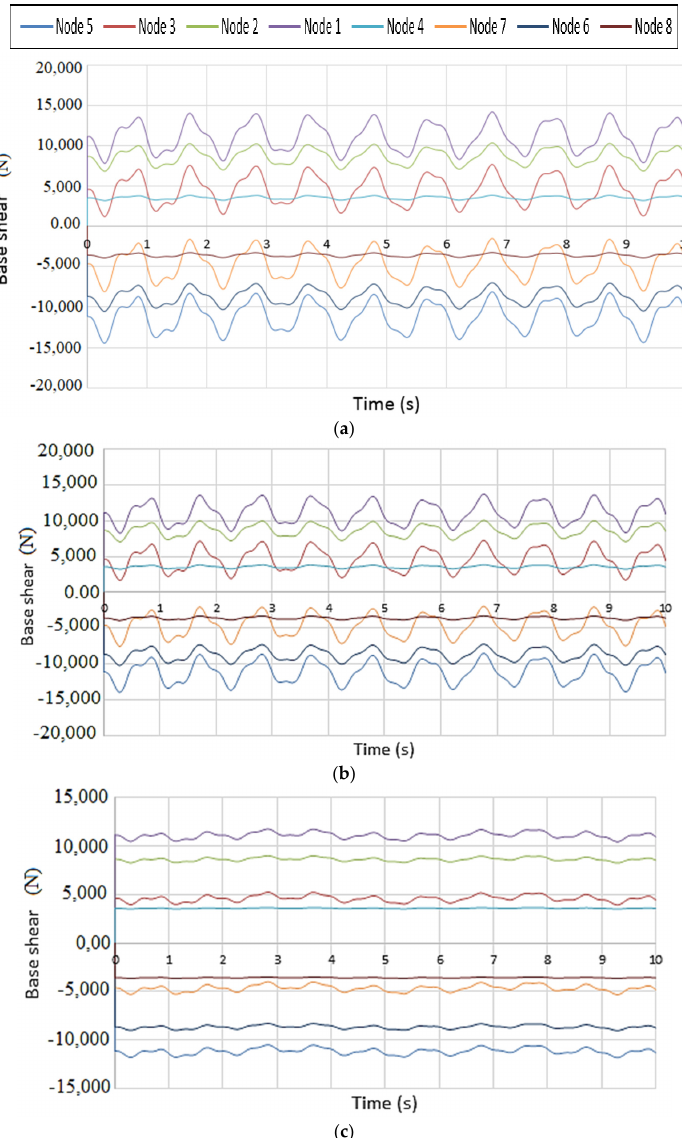
Figure 18. Base shear force in 8 supports of flexible elevated storage tank. ( a ) Base shear (no baffle); ( b ) base shear (horizontal baffle); ( c ) base shear (annular baffle).